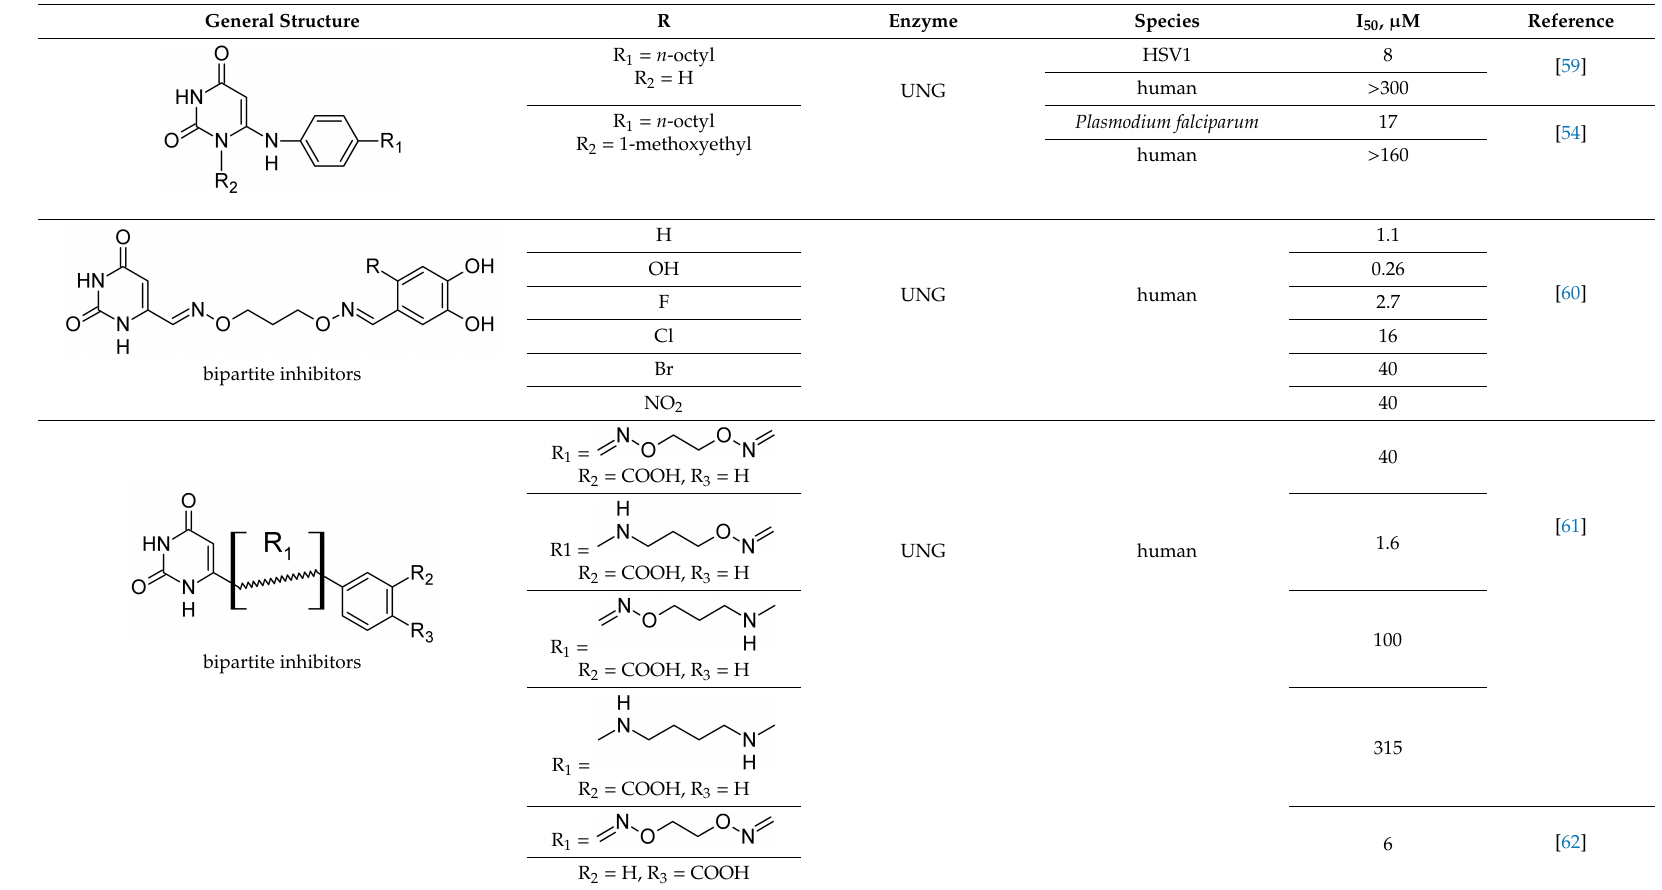
Table 2. Properties of selected DNA glycosylase inhibitors discussed in this